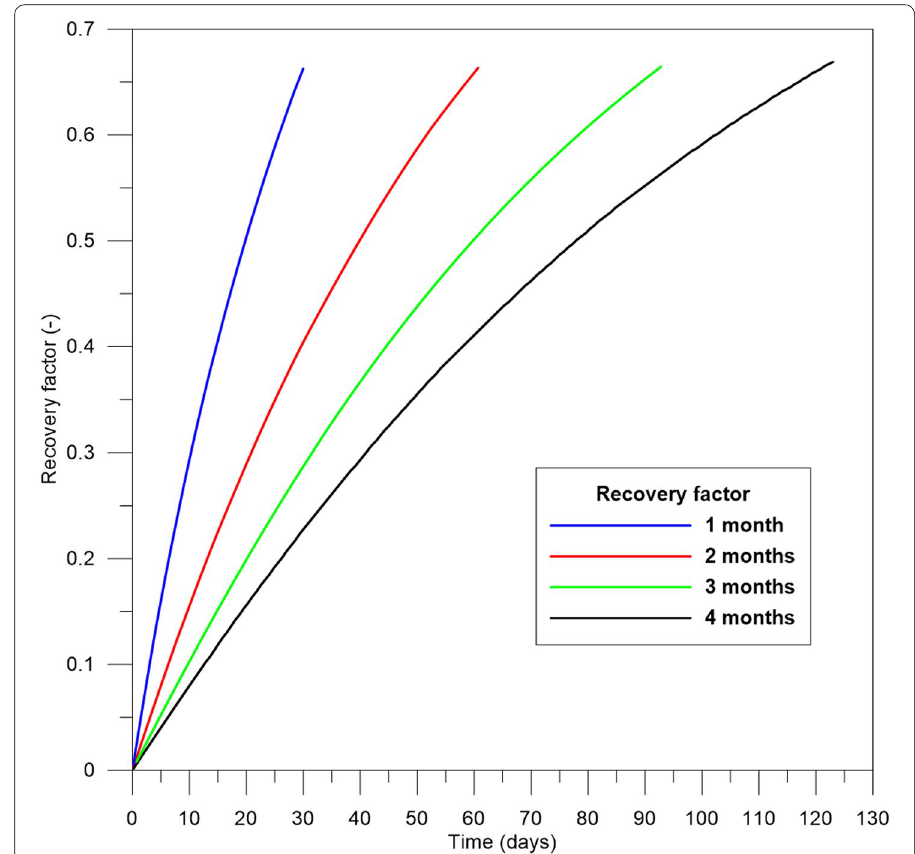
Fig. 4 Recovery factors for varying storage phases of 1 month (blue curve), 2 months (red curve), 3 months (green curve) and 4 months (black curve). Values are normalized to total surplus energy stored during storage